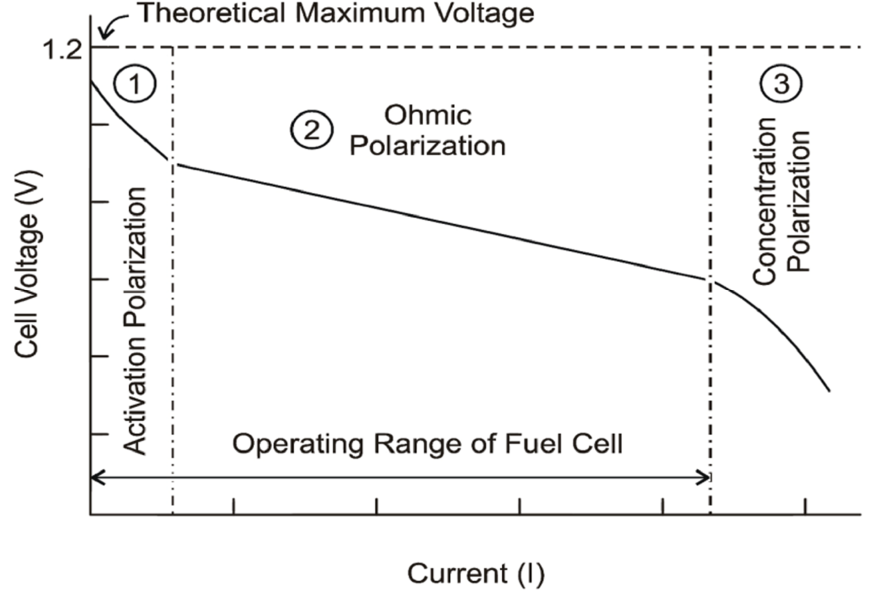
Figure 4. Polarization curves representing active, ohmic, and activation regions [66].